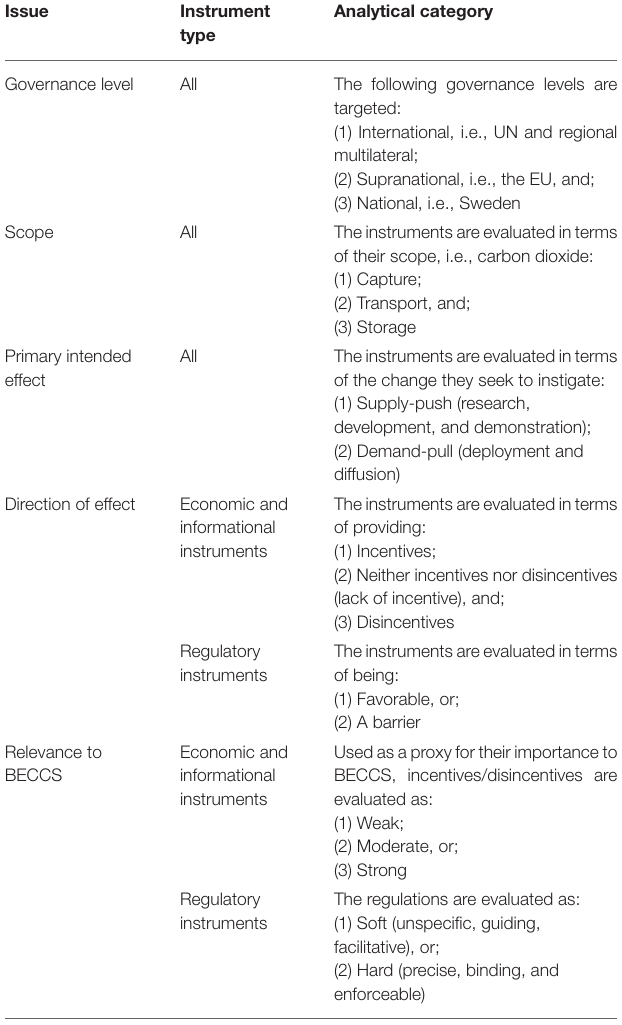
TABLE 1 | Summary of the analytical framework to categorize and specify the relevance of economic, regulatory, and informational policy instruments for BECCS